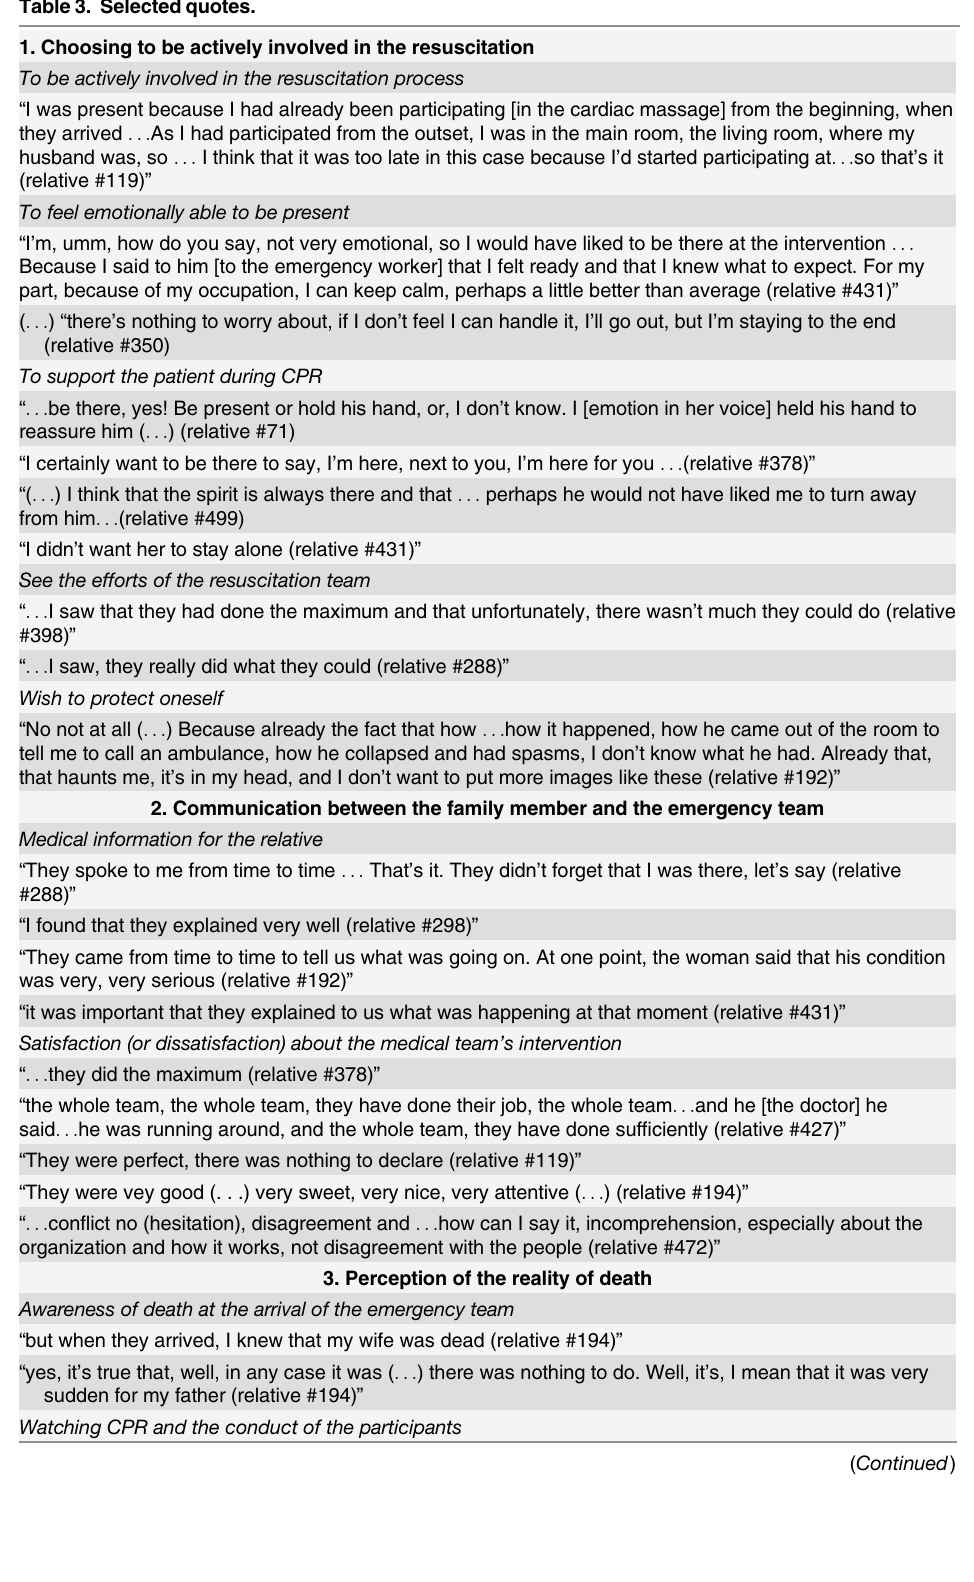
Table 3. Selected